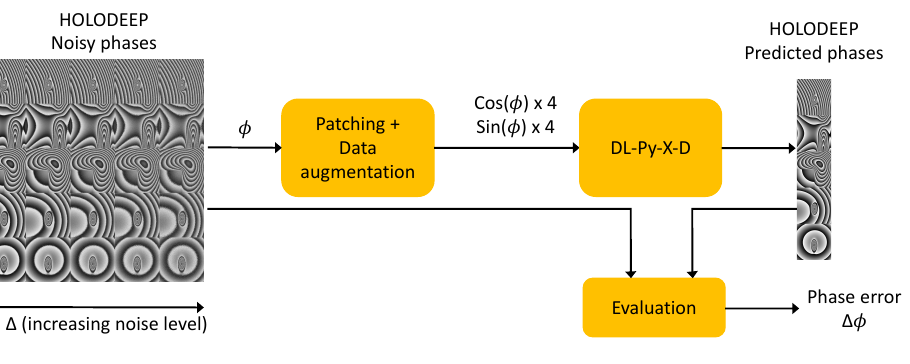
Figure 3. Global overview of the training stage of the